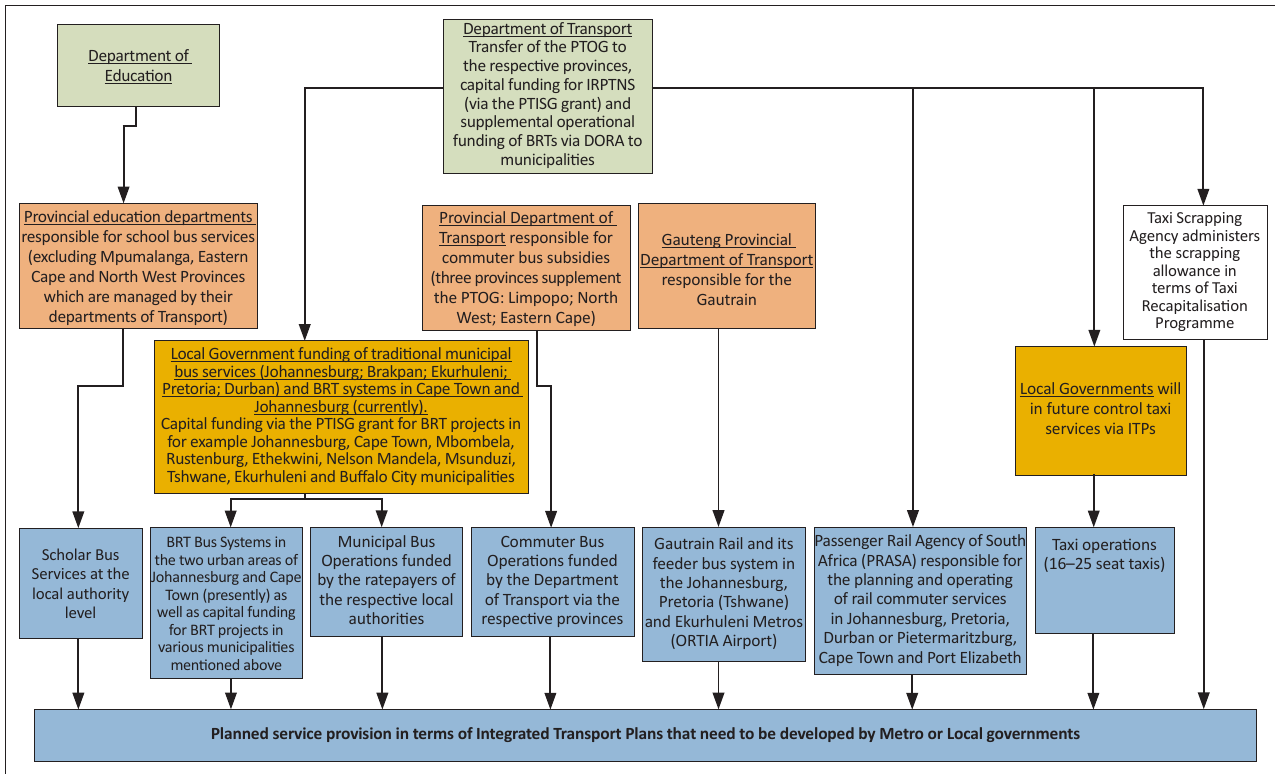
FIGURE 2: Illustration of the numerous funding streams that are currently used to fund public transport in South